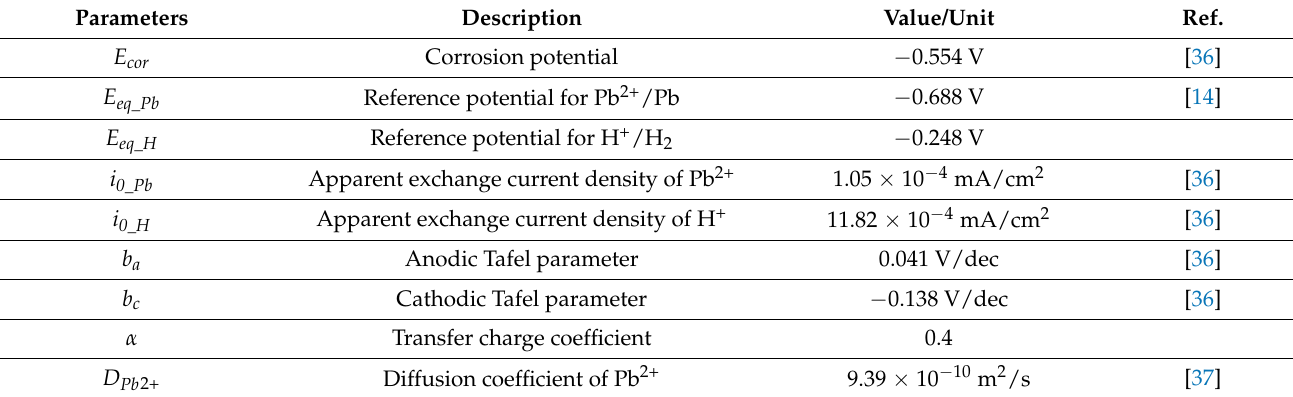
Table 1. Value of some parameters and units.